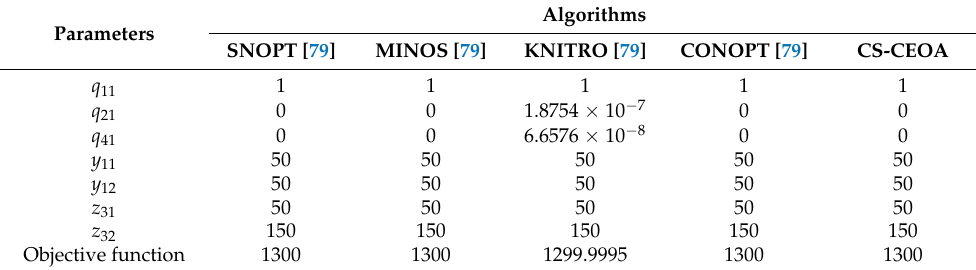
Table 8. The results of this problem are presented in Figure